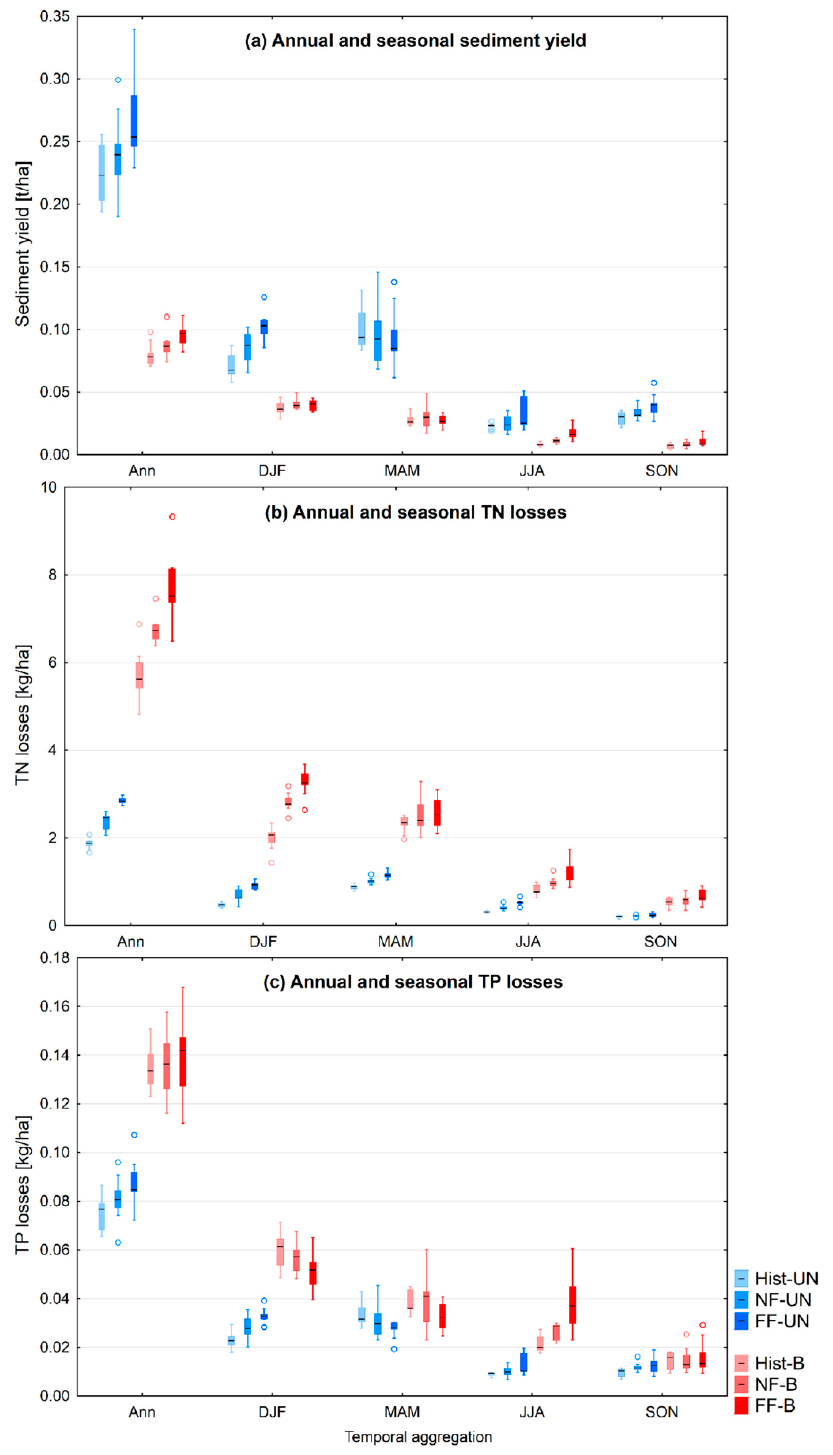
Figure 10. Multi-model ensemble projections of annual and: seasonal sediment ( a ); TN ( b ); and TP ( c ) losses, for the near (NF) and the far (FF) future under RCP 4.5 in comparison to the historical (Hist) period. B stands for the Barycz catchment and UN stands for the Upper Narew catchment.